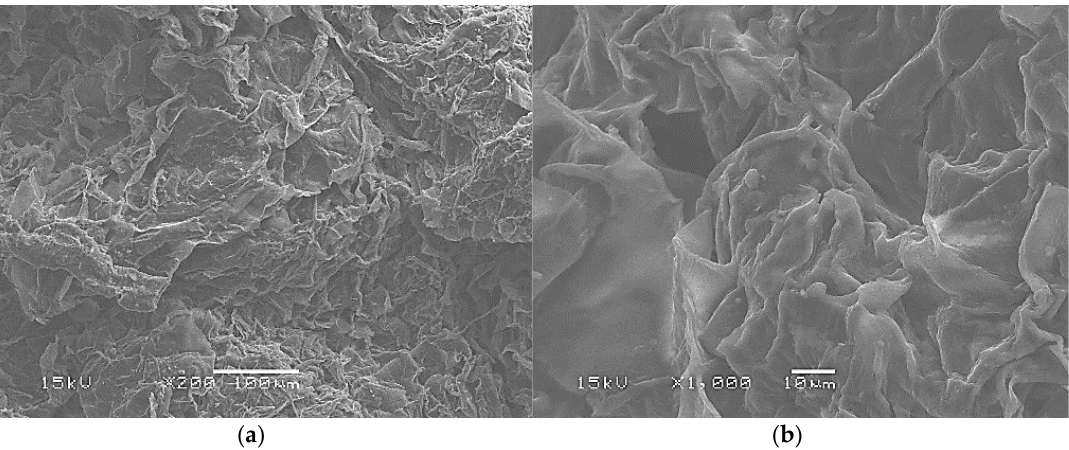
Figure 8. Beet pulp raw material SEM micrographs: ( a ) × 200; ( b ) × 1000.